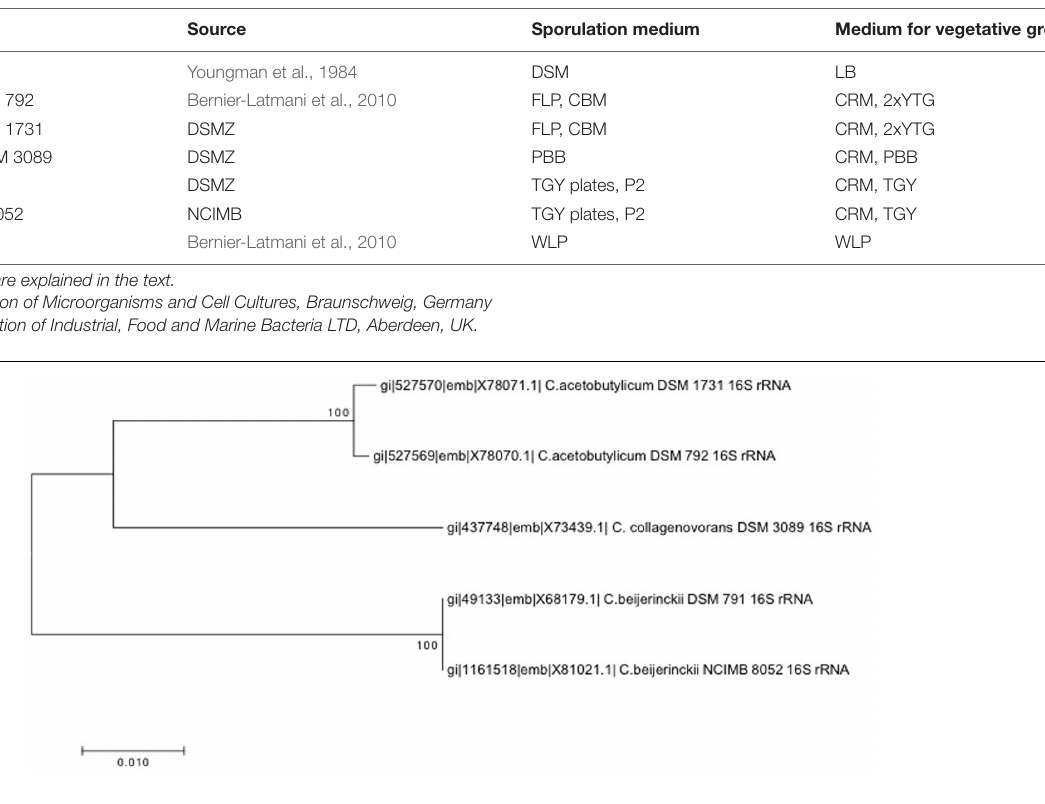
FIGURE 1 | 16S rRNA-based neighbor-joining phylogenetic tree constructed using MEGA7 with the p -distance method and the Bootstrap method (1000 replications).